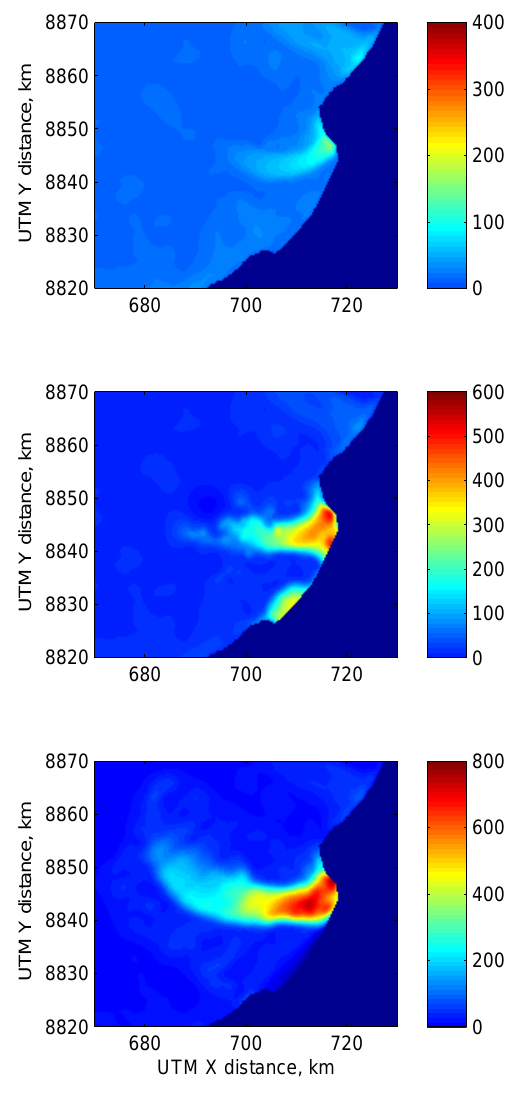
Figure 3. Smoothed and patched (see main text for details) ob- ma − 1 ) over Nor- Fig. 2. Observed winter velocity magnitude (in Fig. 3. Smoothed and patched (see main text for details) observed served winter velocity magnitude (in ma − 1 ) over B3, ASF, from daustlandet from 1995 (top), 2008 (middle) and 2011 (bottom). B3 winter velocity magnitude (in ma − 1 ) over B3, ASF from 1995 1995 (top), 2008 (middle) and 2011 (bottom). Note the different is the most prominent outlet glacier on the eastern side. Dark blue (top), 2008 (middle) and 2011 (bottom). Note the different colour indicates no data. UTM zone is 33N. Neighbouring ice cap Vestfona colour scales. Dark blue indicates no data. UTM zone is scales. Dark blue indicates no data. UTM zone is 33N. (VSF) is also shown.